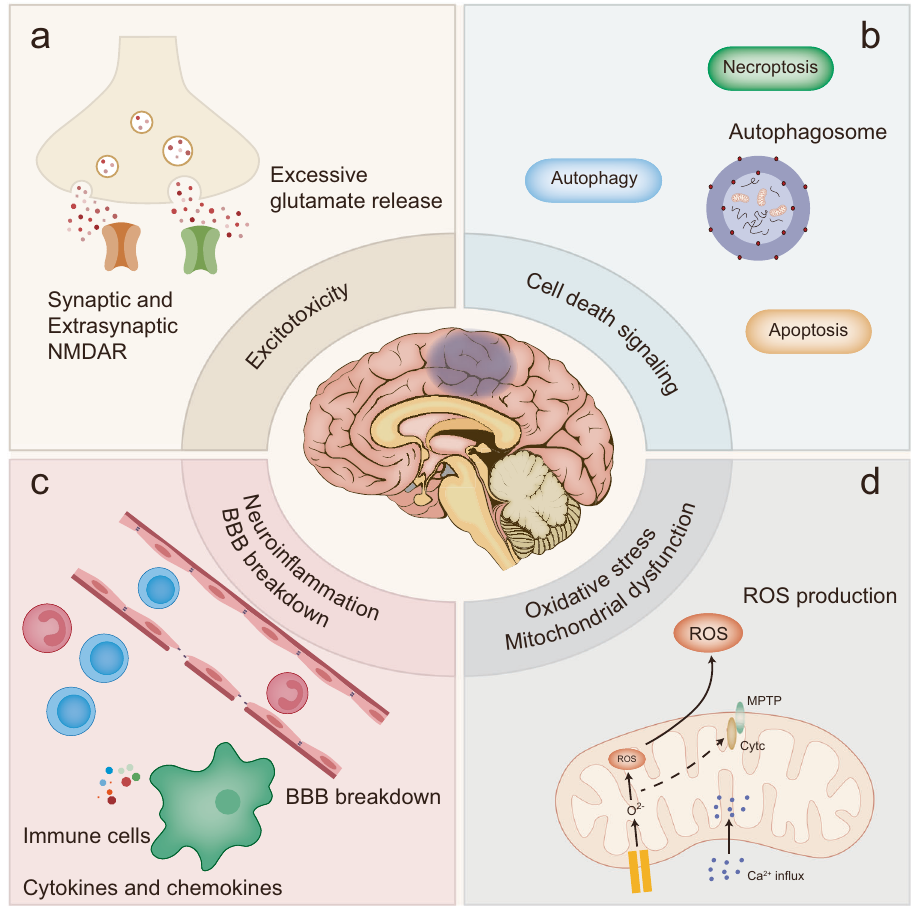
Fig. 2 A brief summary for the pathophysiology involved in ischemic stroke. a Excitotoxicity in ischemic stroke, in which excessive glutamate are released and both synaptic and extra-synaptic NMDARs are involved; b Cell death signaling pathways, which mainly involves autophagy, apoptosis and necroptosis in ischemic stroke; c Neuroin fl ammation and BBB breakdown in ischemic stroke. Here we've presented the participation of various immune cells and chemokines and cytokines released, which thus contribute to blood-brain barrier